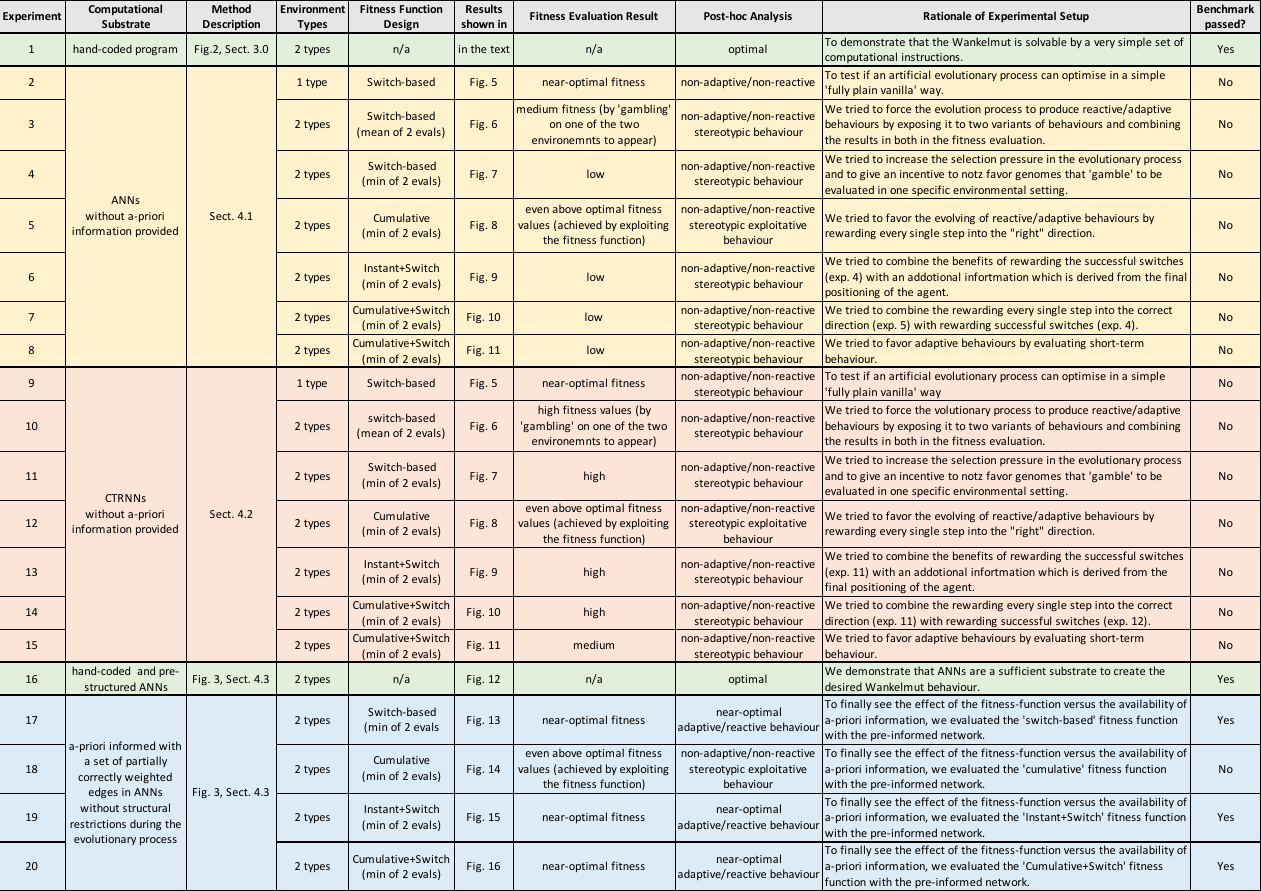
Figure 3. Summary of the experimental settings and results. The rightmost column indicates the combination of methods for which a successful Wankelmut behavior was